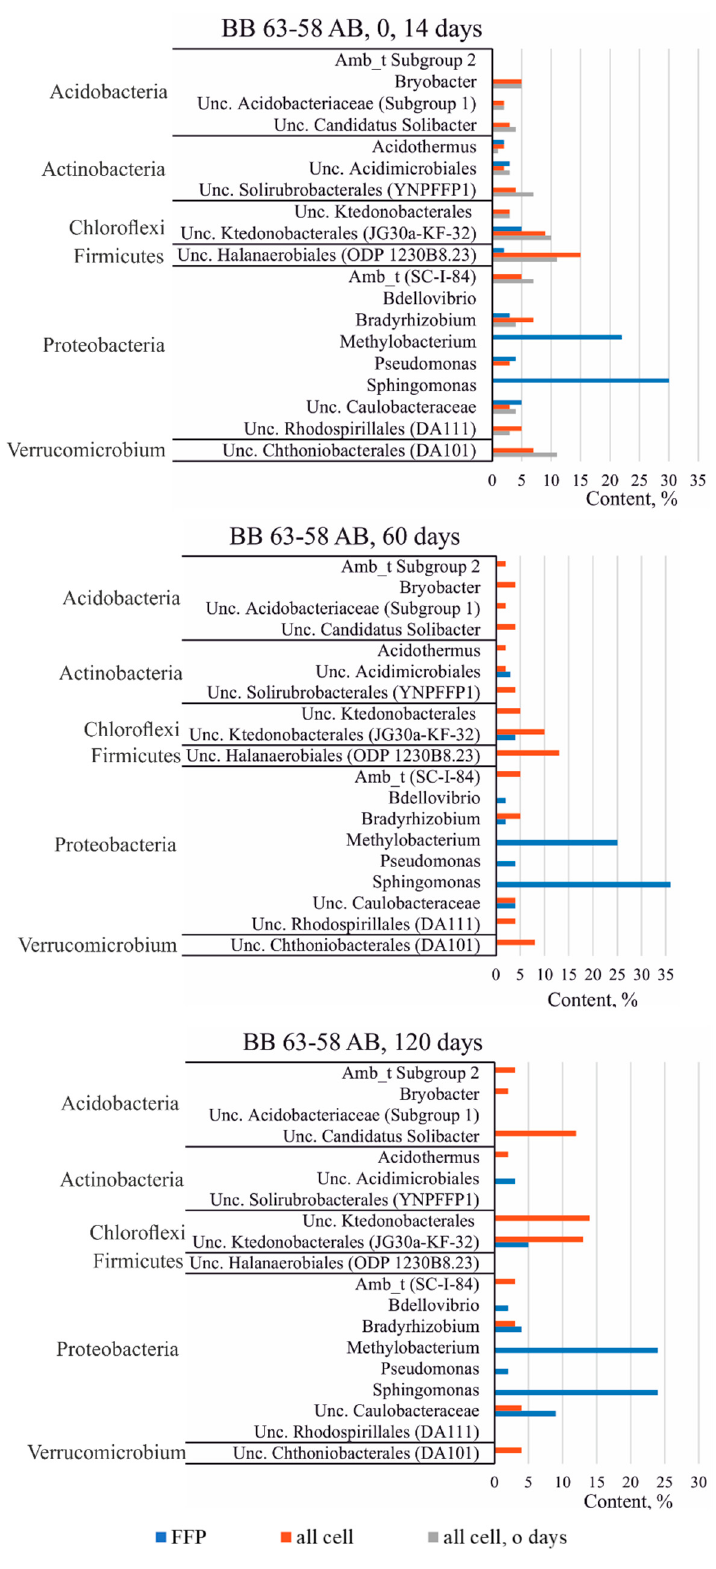
Figure 7. Distribution of dominant groups during succession in the horizon AB, BB 63–58 profile, 20 °C (phyla with content greater than 2% are presented).